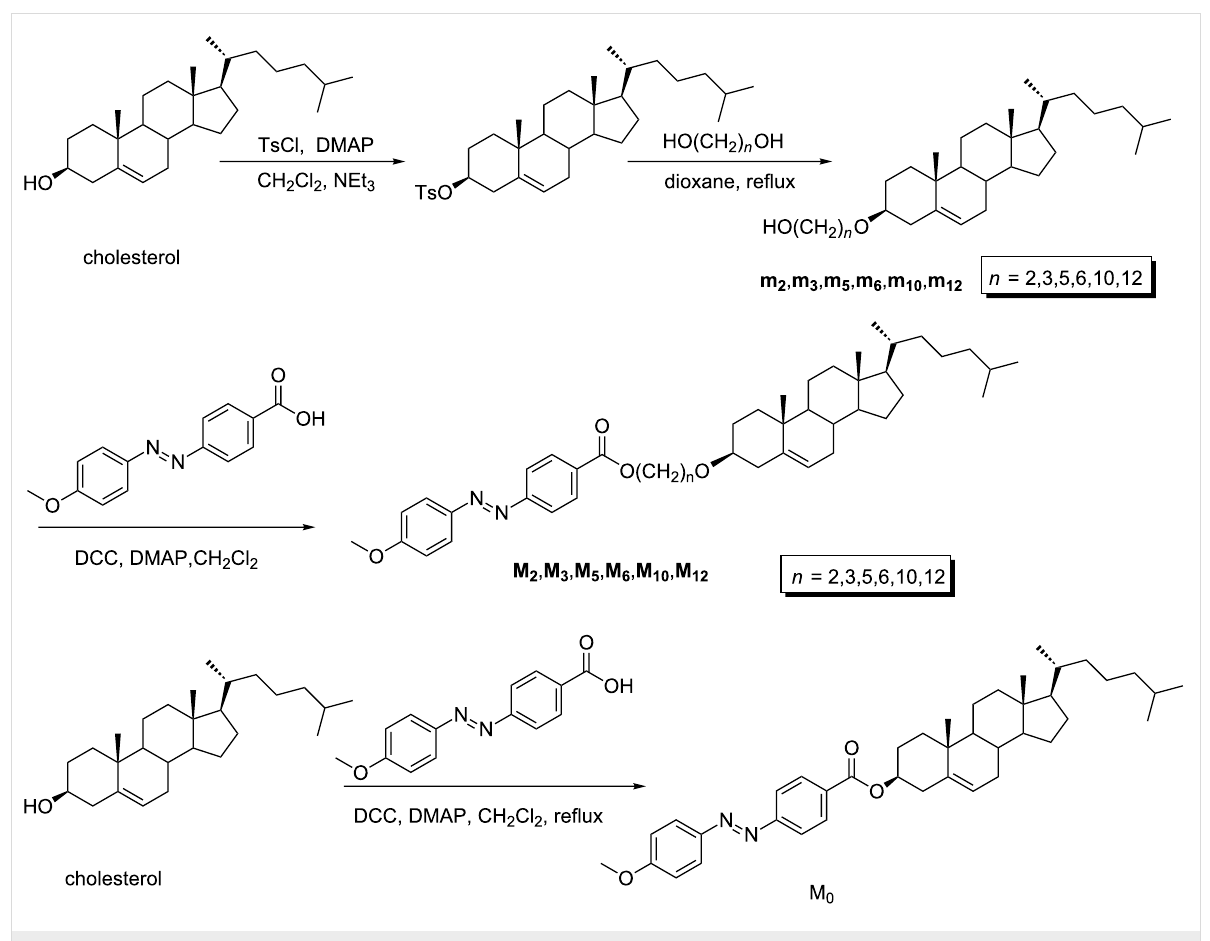
Scheme 1: Synthesis route and chemical structure of the